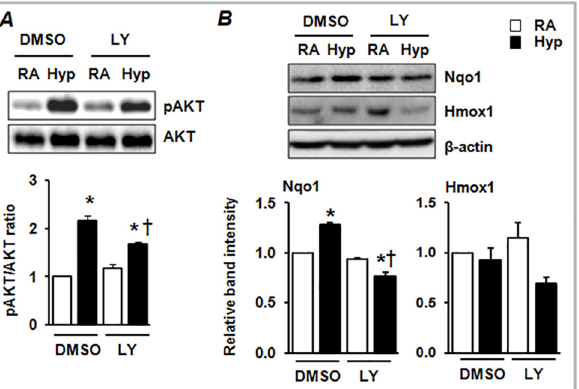
Fig 2. The effects of PI3K/AKT inhibition on Nrf2 target gene expression in mice. Total proteins were extracted from the lungs of vehicle- or LY-treated Nrf2 +/+ and Nrf2 – / – mice exposed to room air or hyperoxia. Equal amounts of proteins were separated and transferred onto PVDF membranes, and probed with anti- pAKT, anti-AKT, anti-Hmox1 or anti-Nqo1 antibodies. β -actin was used as a loading control. The effect of PI3K inhibition on AKT phosphorylation (A) and Nqo1 and Hmox1 expression (B) in the lungs of room air- or hyperoxia-exposed mice. Band intensities were calculated using Image J software and the graphs represent the ratios of pAKT/AKT (n = 4), Hmox1/ β -actin (n = 6) and Nqo1/ β -actin (n = 6). * P < 0.05, hyperoxia vs room air; † P < 0.05, vehicle vs LY.